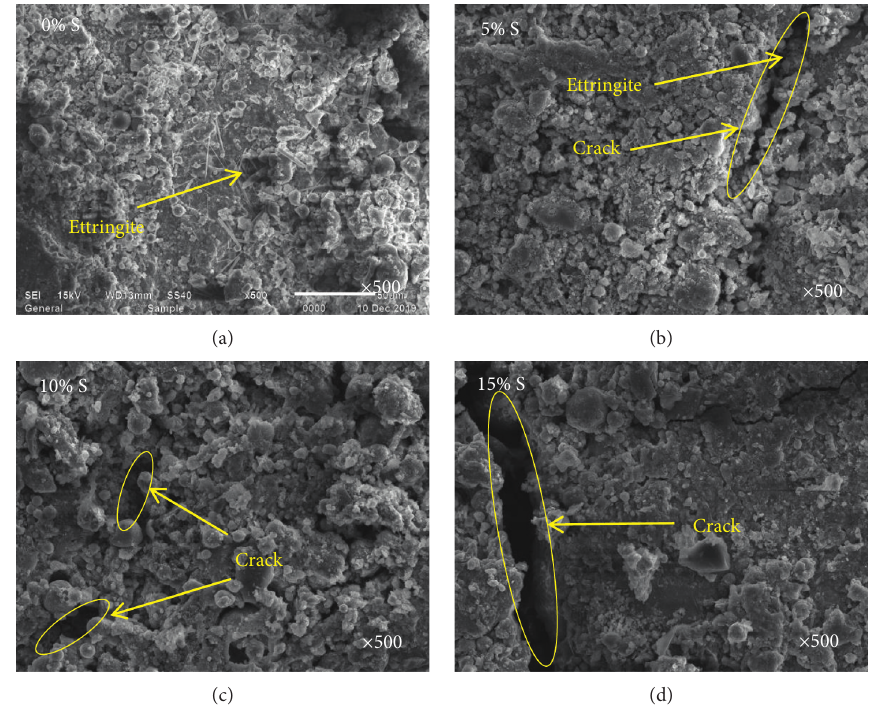
Figure 8: SEM images of the surface layers of CGFB samples immersed in 0–15% sodium sulfate